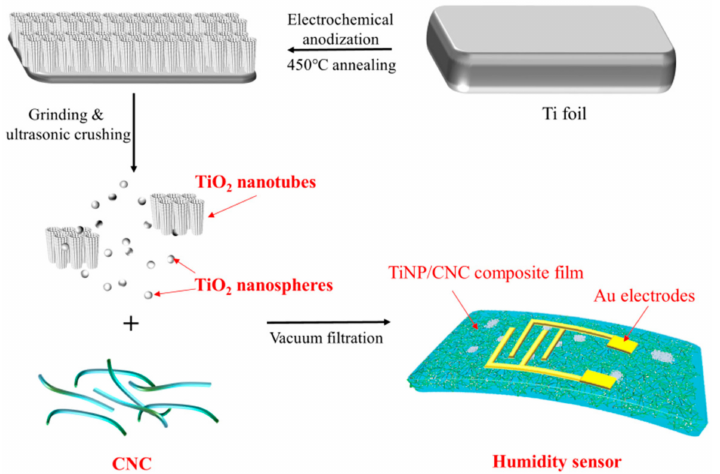
Figure 1. A schematic diagram of the TiNP/CNC-based humidity sensor preparation